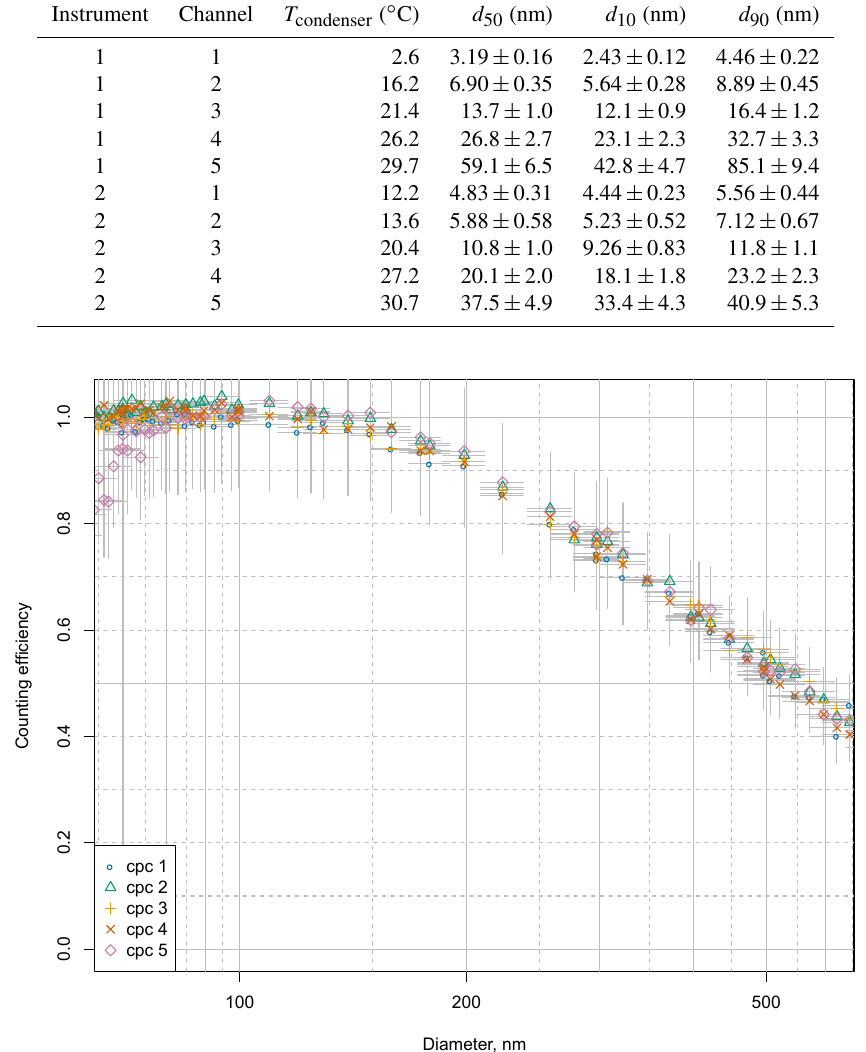
Figure 6. Counting efficiency of NMASS 1 against particle diameter for diameters between 65 and 650nm using atomized ammonium sulfate particles. The decay of counting efficiency with particle diameter at diameters above 150nm is mainly caused by particle impaction on the orifice at the instrument inlet. At particle diameters above 70nm, all 5 channels (shown by the different colours and symbols in the legend) have the same counting efficiency. Particle counting efficiency is 100% at 109nm and drops to 50% at 546nm. At diameters < 70nm, the = 59 . 1 ± 6.5nm) is already roll-off in detection efficiency of CPC5 ( d p 50